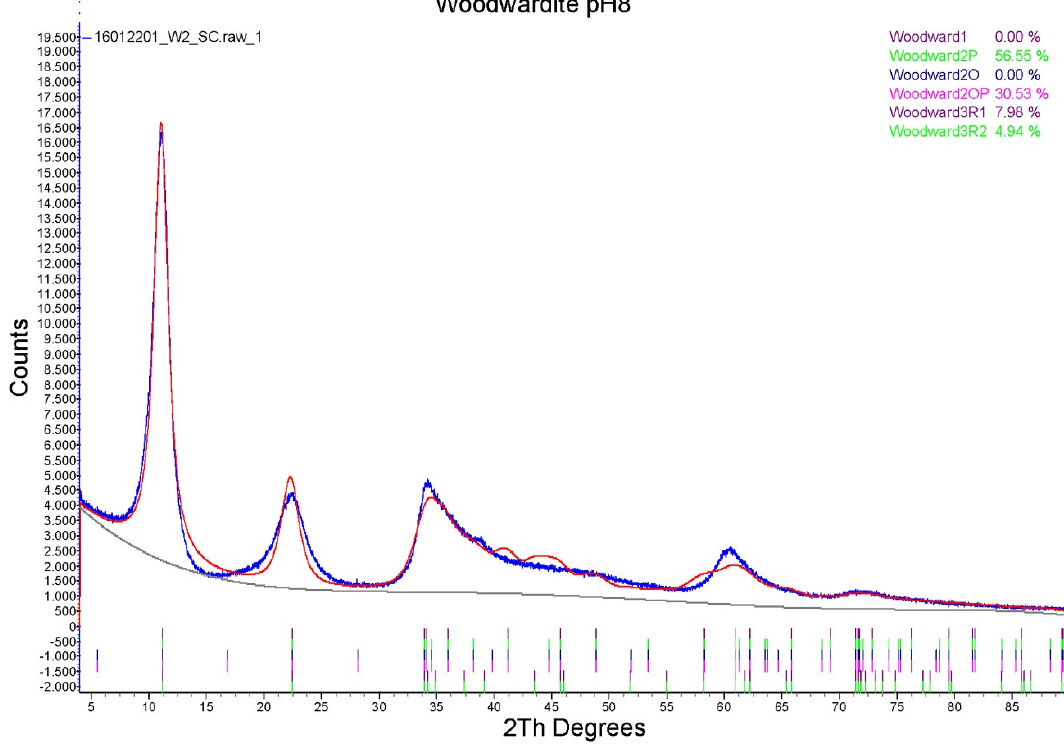
Table 1. Chemical composition of the synthetic samples. The values are expressed in wt %.